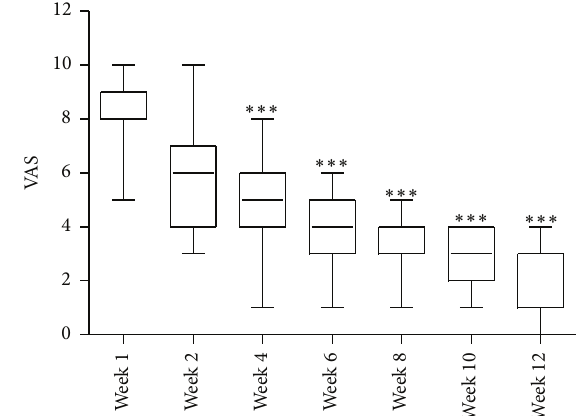
Figure 2: Time course self-reported postoperative visual analogue pain score (VAS) from patients with Achilles tendinosis, showing median and minimum and maximum scores, where ∗∗∗ 𝑝 < 0.001 versus preop (week 1)